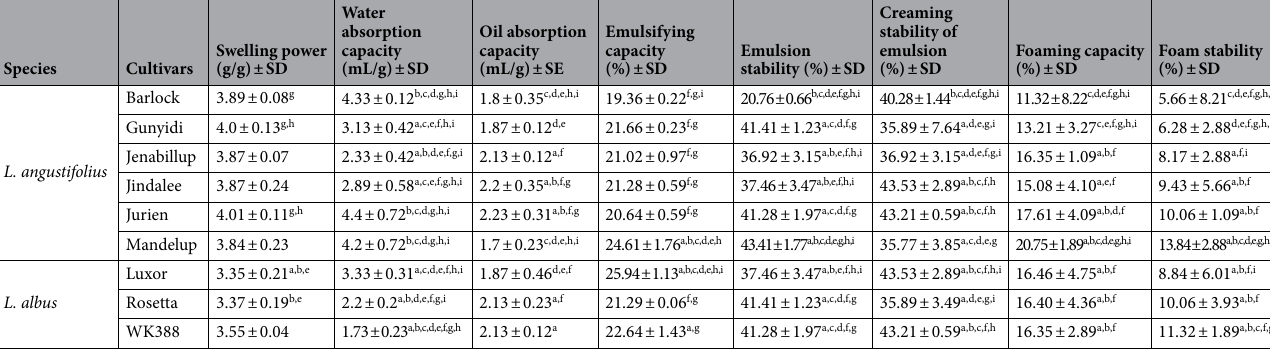
Table 5. Functional properties of different lupin cultivars. Data are means of three replicates with standard deviations (SD). Data within the same column with different superscripts are significantly different, pair-wise comparison by Post Hoc Tukey test ( a P < 0.05 vs. Barlock; b P < 0.05 vs. Gunyidi; c P < 0.05 vs Jenabillup; d P < 0.05 vs. Jindalee; e P < 0.05 vs Jurien; f P < 0.05 vs. Mandelup; g P < 0.05 vs Luxor; h P < 0.05 vs Rosetta; i P < 0.05 vs